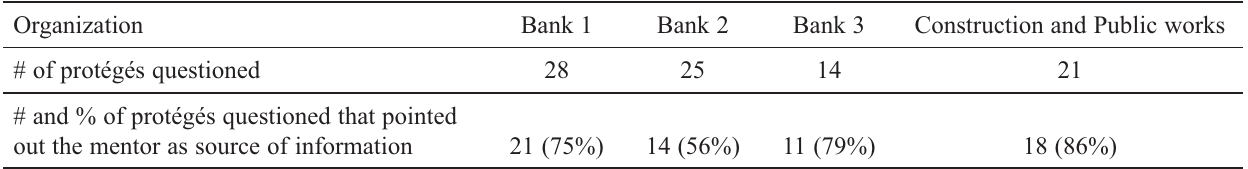
Table 4. Results from the fi eld